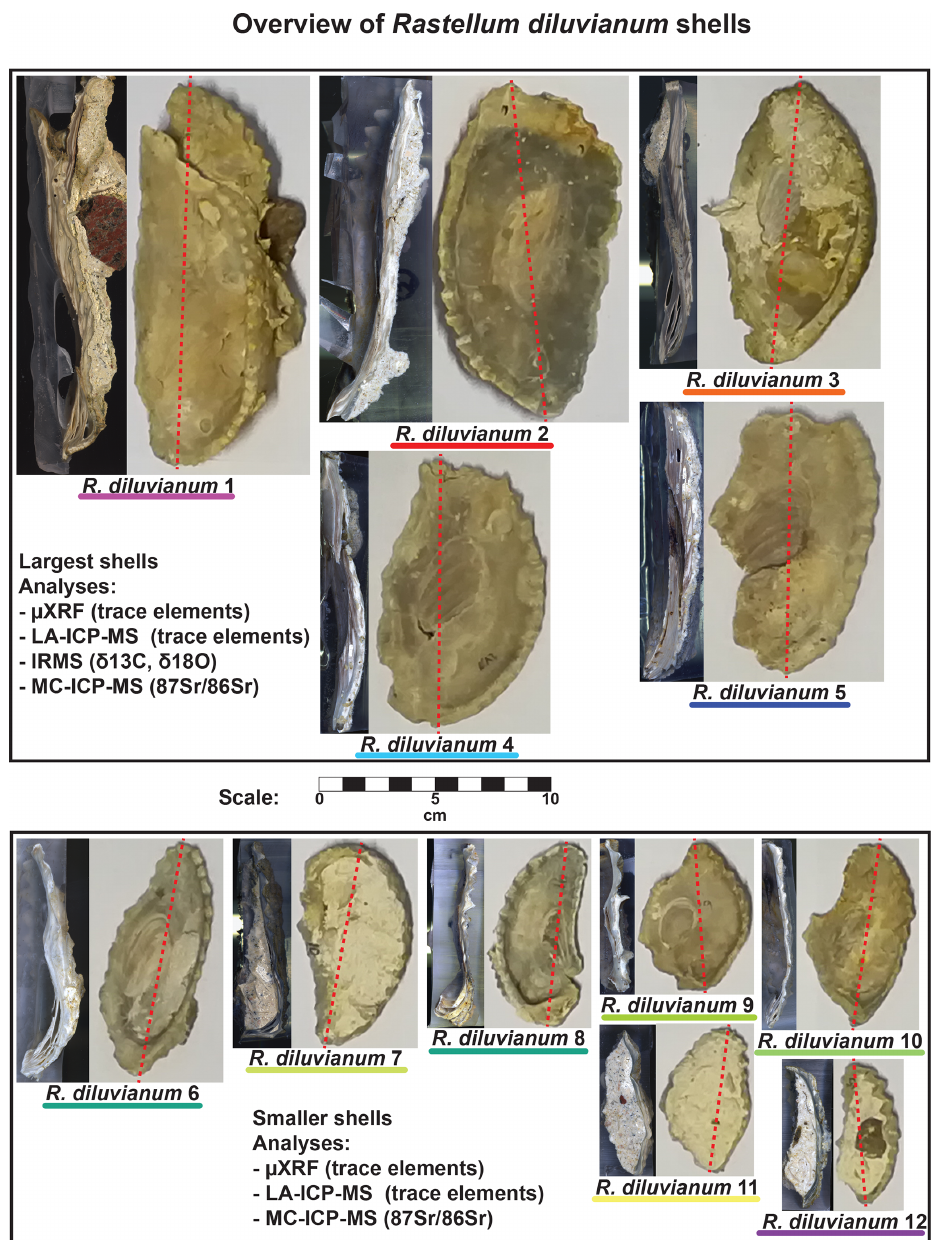
Figure 2. Overview of the 12 Rastellum diluvianum shells used in this study. All shells are depicted at the same scale (see scale bar in center of image). Colors of the lines under sample names correspond to the colors of the lines in Figs. 4, 6, 8 and 10. Every shell is represented by an image of the inside of the valve analyzed as well as a color scan of the cross section through the shell on which high-resolution analyses were carried out. Dashed red lines show the location of these cross sections. The largest five shells (1–5, in top panel) were sampled for IRMS analyses ( δ 13 C and δ 18 O). All shells were subjected to micro-X-ray fluorescence (µXRF), laser ablation inductively coupled plasma mass spectrometry (LA-ICP-MS) and multi-cup inductively coupled plasma mass spectrometry (MC-ICP-MS) analyses. Full-size versions of the high-resolution color scans of shell cross sections are provided in de Winter et al.